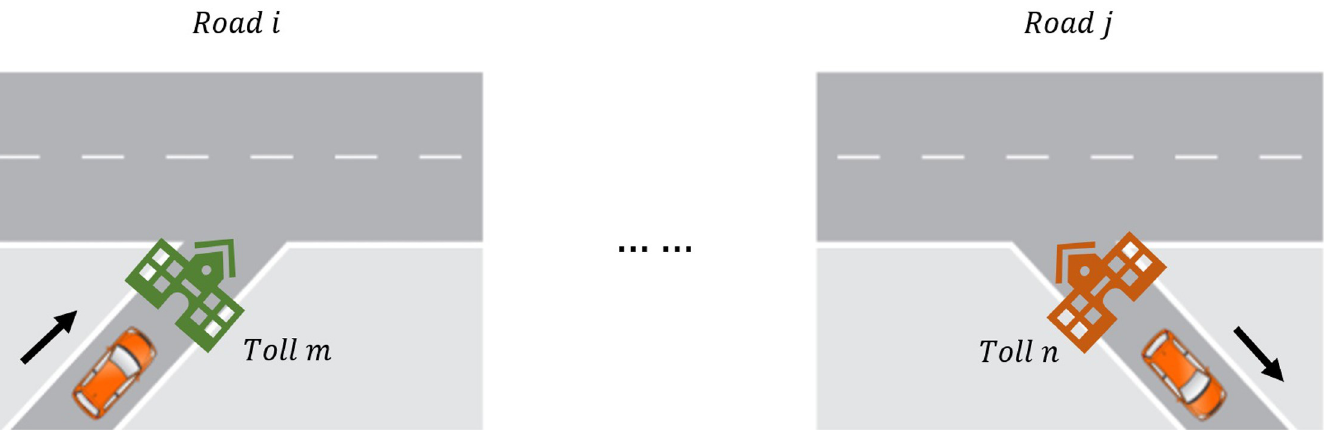
Fig 1. Expressway OD pair